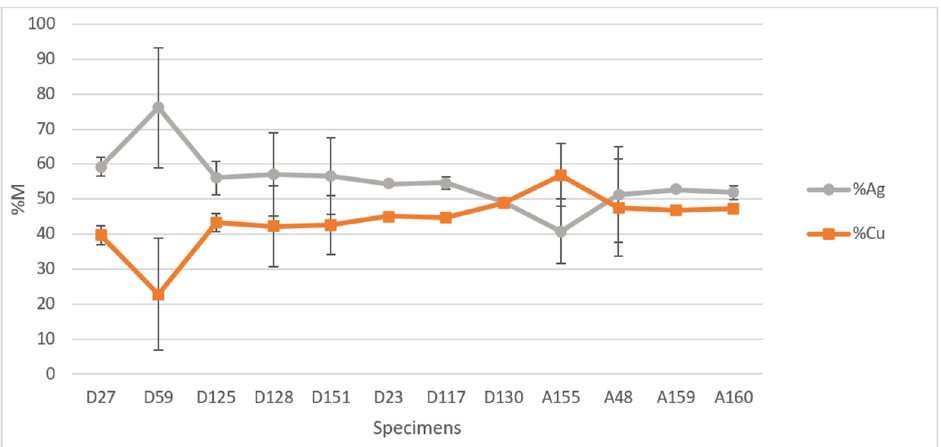
Figure 4. Relative concentration of Ag and Cu in the 12 coins (8 denarii and 4 antoniniani) analysed by ICP-AES. Data are given as mean ± RSD%.